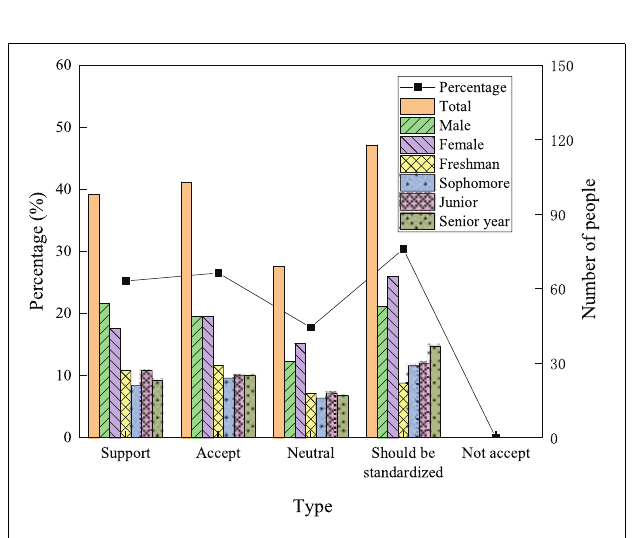
FIGURE 5 | Acceptance of network buzzwords by the surveyed college students.